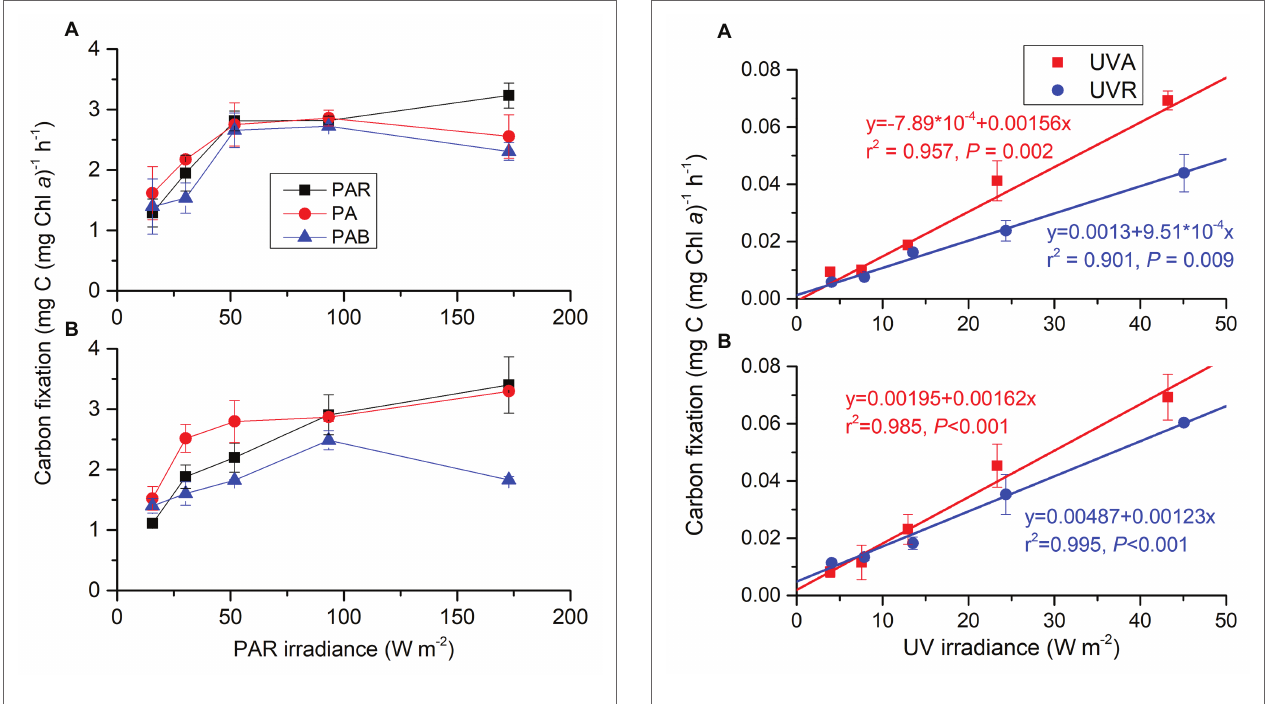
FIGURE 5 | Photosynthetic carbon fixation rates of S. costatum grown at ambient (A) and lowered CO 2 (B) levels when exposed to different radiation treatments. PAR, photosynthetically active radiation; PA, PAR + UVA, PAB, PAR + UVA + UVB. The error bars indicate the SDs ( n = 3).